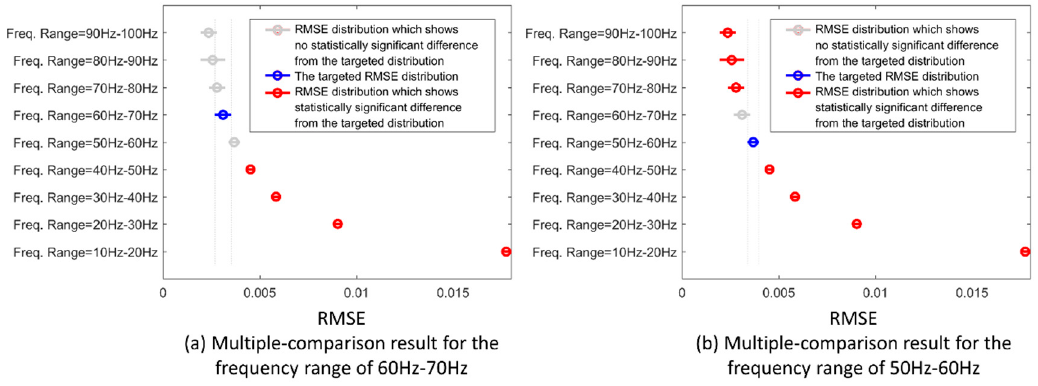
Figure 7. RMSE distributions for different resampling frequency ranges. The circle indicates the mean RMSE and the horizontal line shows the +/- one standard deviations.